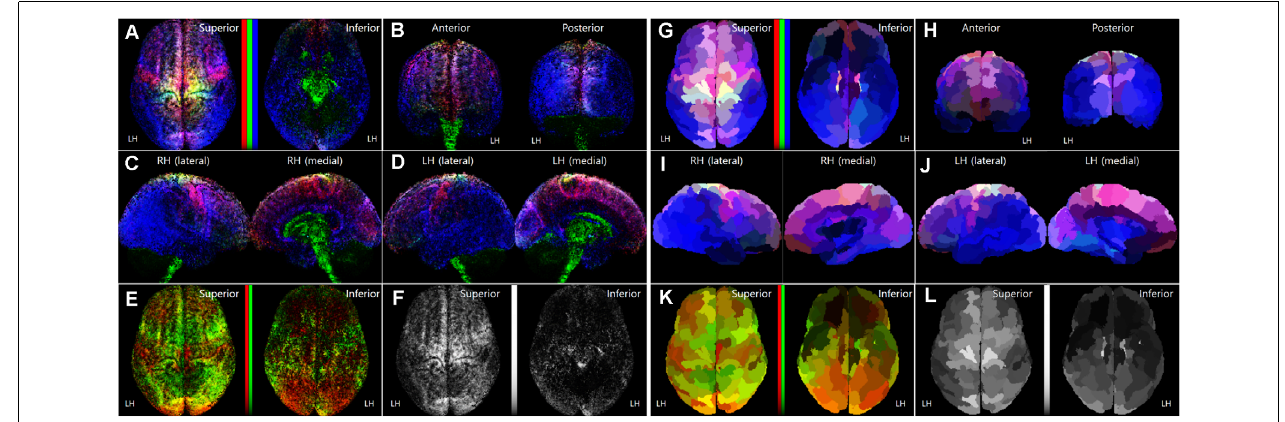
FIGURE 3 | Normalized TRRMs from the 16 subject datasets. (A–F) Averaging image of the voxel-based TDRMs. (G–L) Parcellation-piece-based mean TDRMs (tracks_amount/piece_volume). The display scheme of each image (A–D, G–J) in this figure is the same as Figure 1 . In panels (A,E,F,G,K ), non-linear scaled color bars represent the mapping density of tracks for each fiber type. (A–D, G–J) TDRMs results with the three different primary colors (tracks for commissural fiber = red, projection fiber = green, association fiber = blue). (E,K) TDRMs for the association fiber-related tracks, with the two different primary colors (short association fiber = red, long association fiber = green). (F,L) Total track-density maps using the grayscaled intensity. LH, left hemisphere; RH, right hemisphere; TDRM, track-density ratio